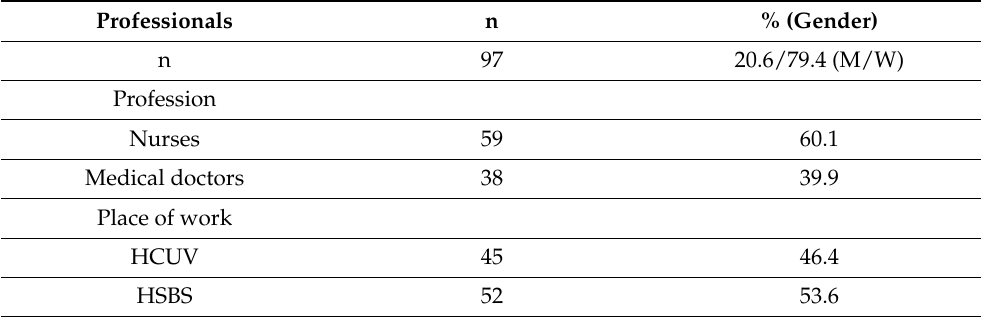
Table 1. Characteristics of the group of healthcare professionals